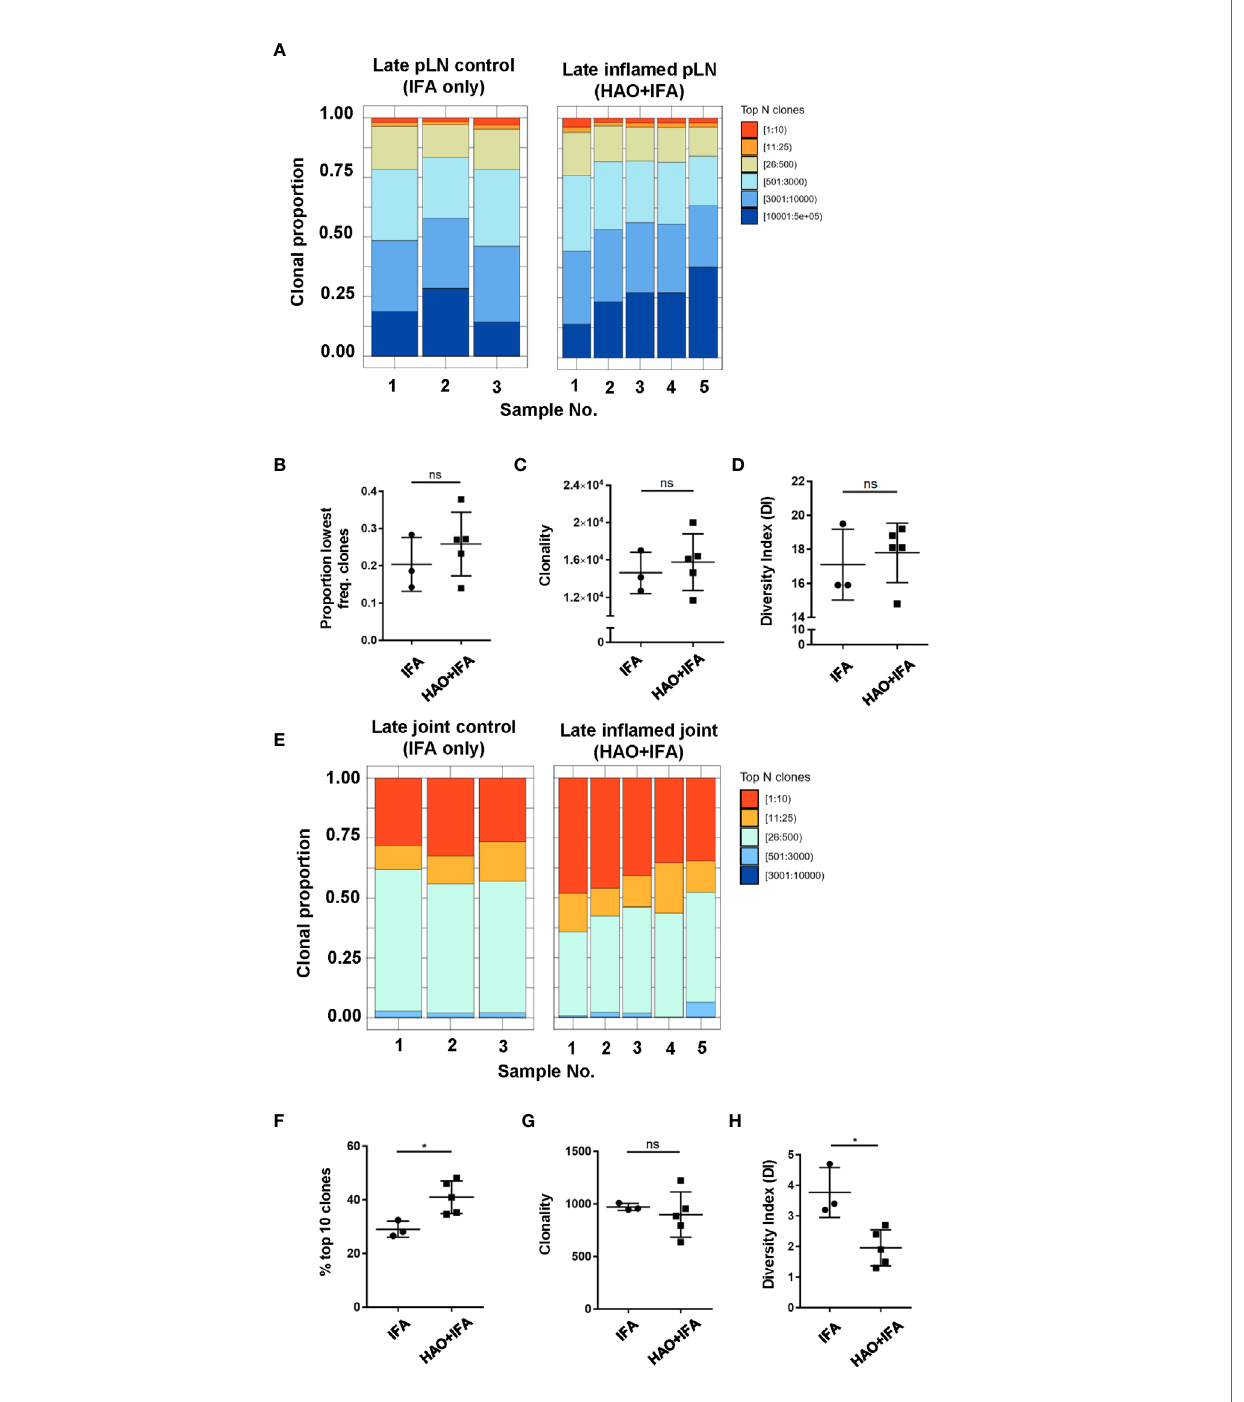
FIGURE 3 | Characterisation of antigen experienced endogenous CD4 T cell repertoires from in fl amed pLNs and joints and IFA controls at the late phase. Proportion of the top 10 most frequently occurring clones, followed by the next 25, 500, 3000, 10,000, and 100,000 most frequent clones contributing to the endogenous antigen experienced CD4+ T cell repertoire in (A) in fl amed pLNs, and (E) in fl amed joints at the late phase (HAO+IFA) and IFA only controls. (B) Proportion of the least frequently occurring clones in in fl amed pLNs at the late phase and IFA controls. (F) Percentage contribution of the top 10 most frequently occurring clones in in fl amed joints at the late phase and IFA controls. (C , G) clonality, represented as the number of unique CDR3 b DNA sequences, in (C) in fl amed pLNs and IFA controls, and (G) in fl amed joints and IFA controls at the late phase. (D , H) diversity indices of (D) in fl amed pLNs and IFA controls, and (H) in fl amed joints and IFA controls at the late phase. Data is representative of mean ± SD with each point representing individual experimental mice. Data represents 1 experiment with n=5 for the in fl amed group and n=3 for the control group. Groups were compared using unpaired Student ’ s t-test. Stars represent the following p values: *<0.05; ns, not signi fi